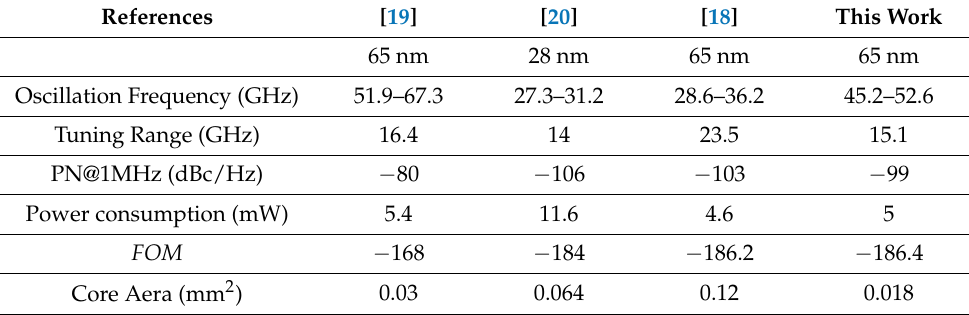
Table 1. VCO performance summary and comparison.